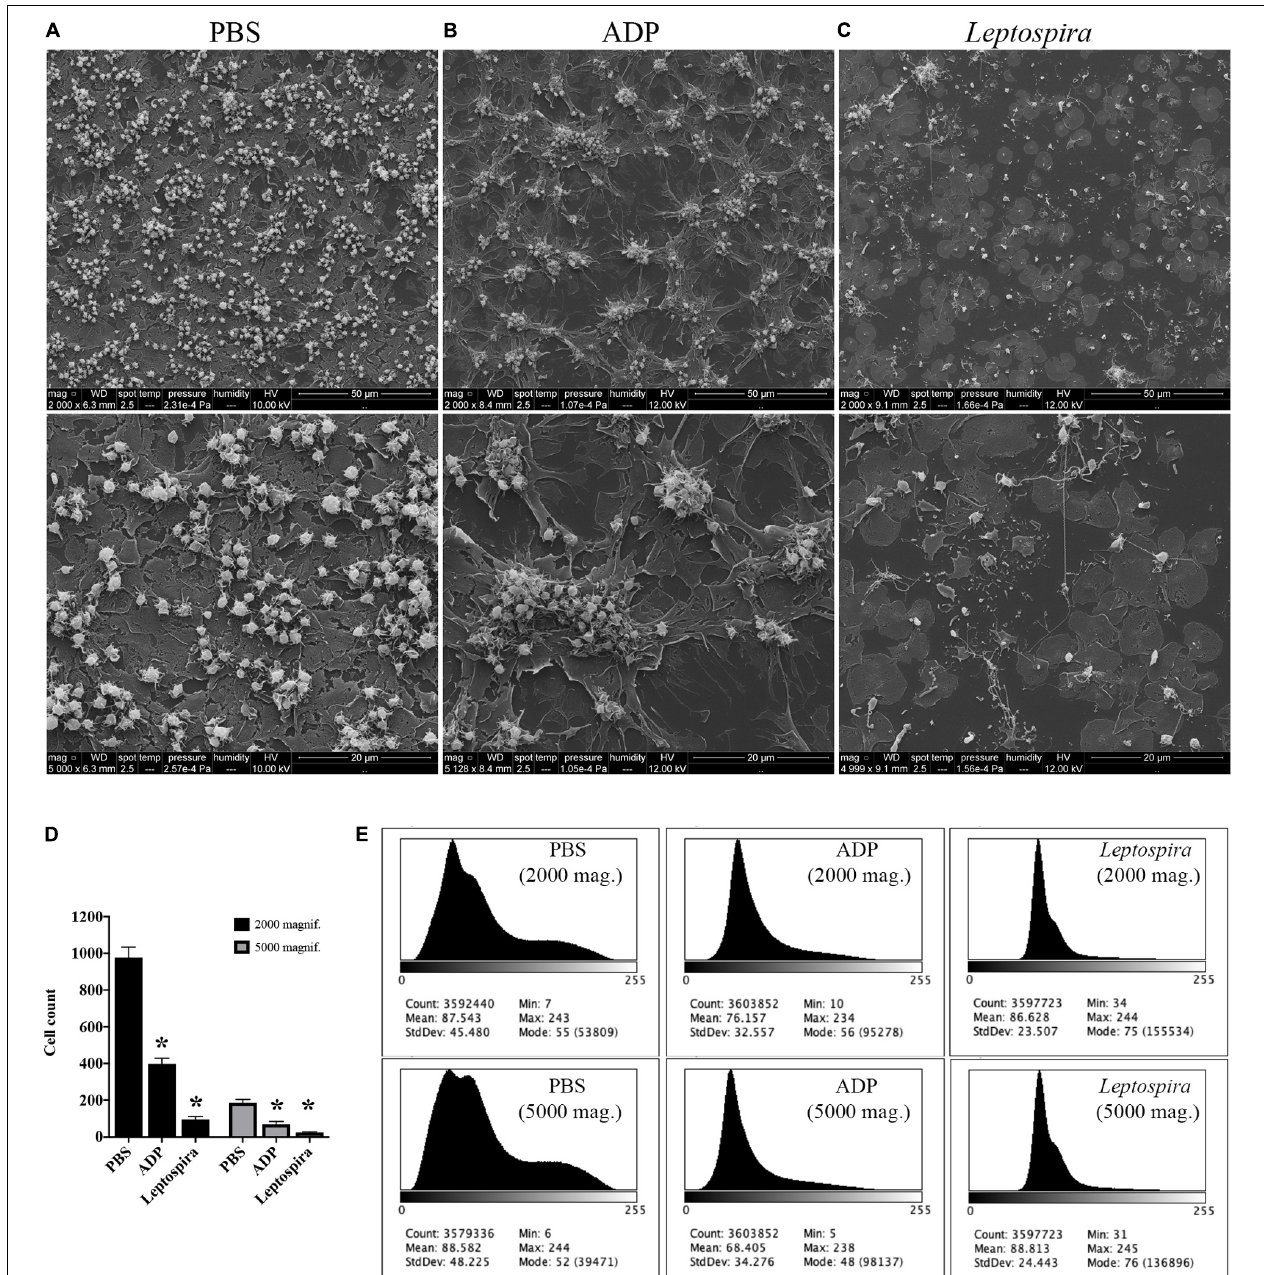
FIGURE 3 | SEM showing the effect of leptospires on pre-adhered washed platelets. Washed platelets were allowed to adhere to coverslip glass surfaces, washed, and treated with PBS ( A ; negative control), ADP ( B ; positive control), or leptospires (C) for 30 min. After washing and fixation, samples were prepared for scanning electron microscopy. Upper panel: 2,000 magnification. Lower panel: 5,000 magnification. The figure shows representative panels of the samples. Two independent experiments were performed, with similar results. (D) Cell count of resting or dendritic platelets observed as individual cells in SEM images. The bars represent the mean ± standard deviation of two independent experiments. One-way ANOVA was used to compare the cell counts of ADP and Leptospira -treated samples with PBS-treated samples (* P > 0.0001). (E) Gray-scale histograms of the representative images, as analyzed by the software ImageJ.